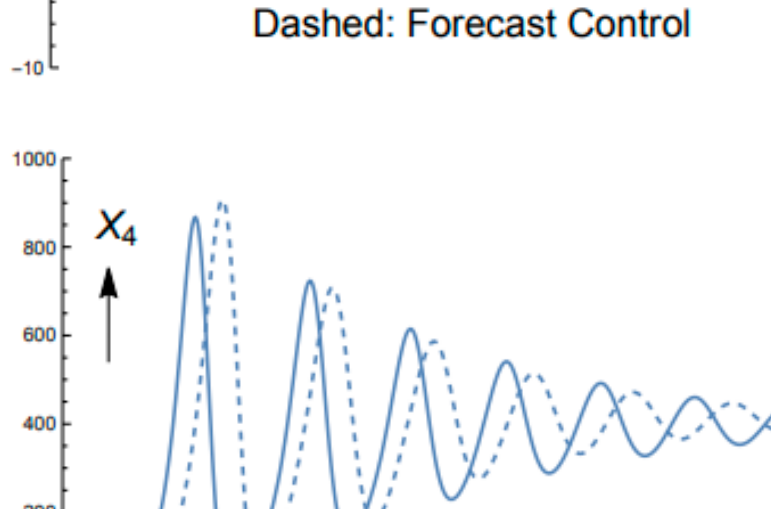
Figure 11. Non-chaotic regime solutions x 1 , x 4 , x 7 for S-LOM (3) using true control (solid curves: λ = 12.0, σ = 7.0) and perturbed/forecast control (dashed curves: λ = 12.6, σ = 4.00 )